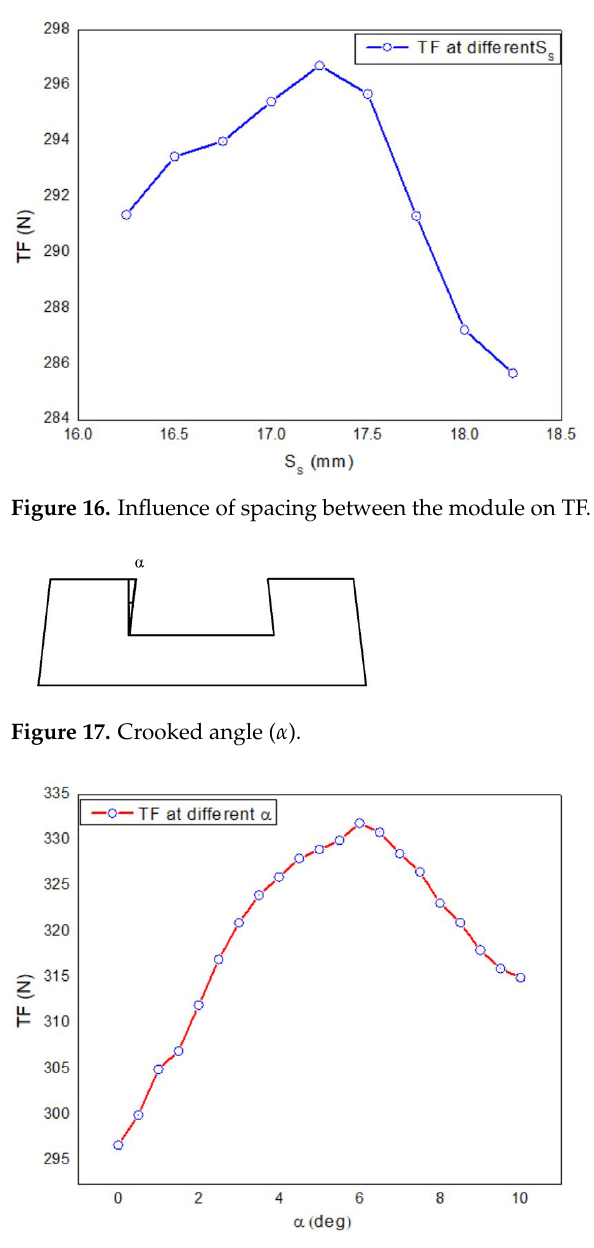
Figure 18. Influence of α on TF. Table 5. Constraints for genetic